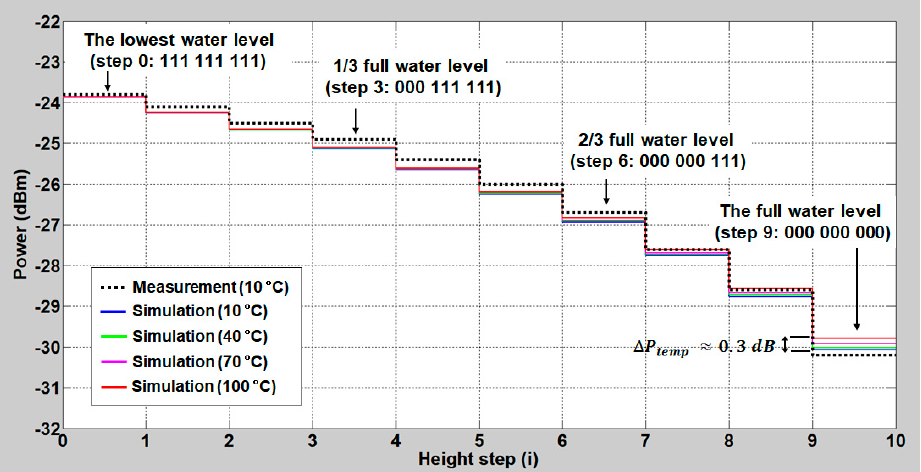
Figure 13. Total optical power as a function of the water level (black dashed line: measured values and solid lines: simulated results at various temperatures).